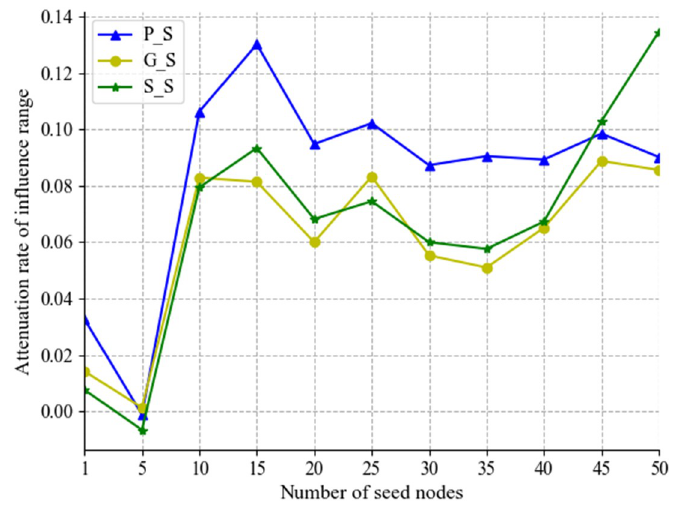
Figure 7. Loss rate of influence spreading of the new seed set obtained by G_S, P_S and S_S.